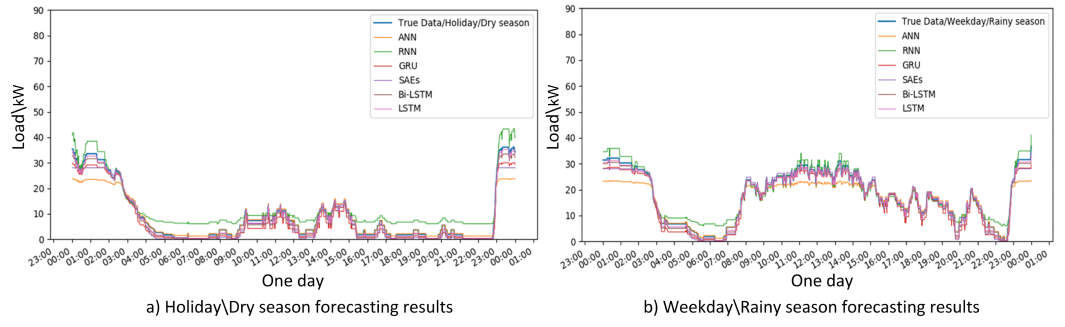
Figure 12. Load forecasting curve effect comparison graph of holiday (dry) and weekday (rainy).